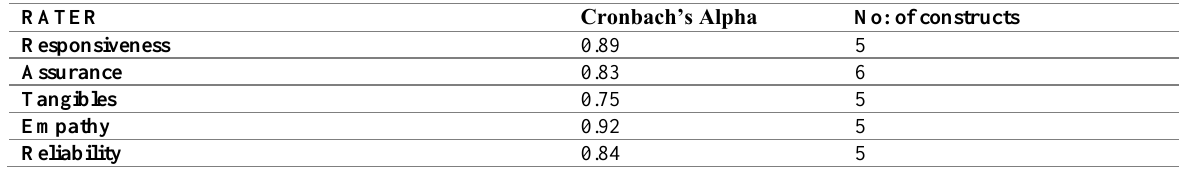
Table 1: Cranach Alpha Results for Each Rater